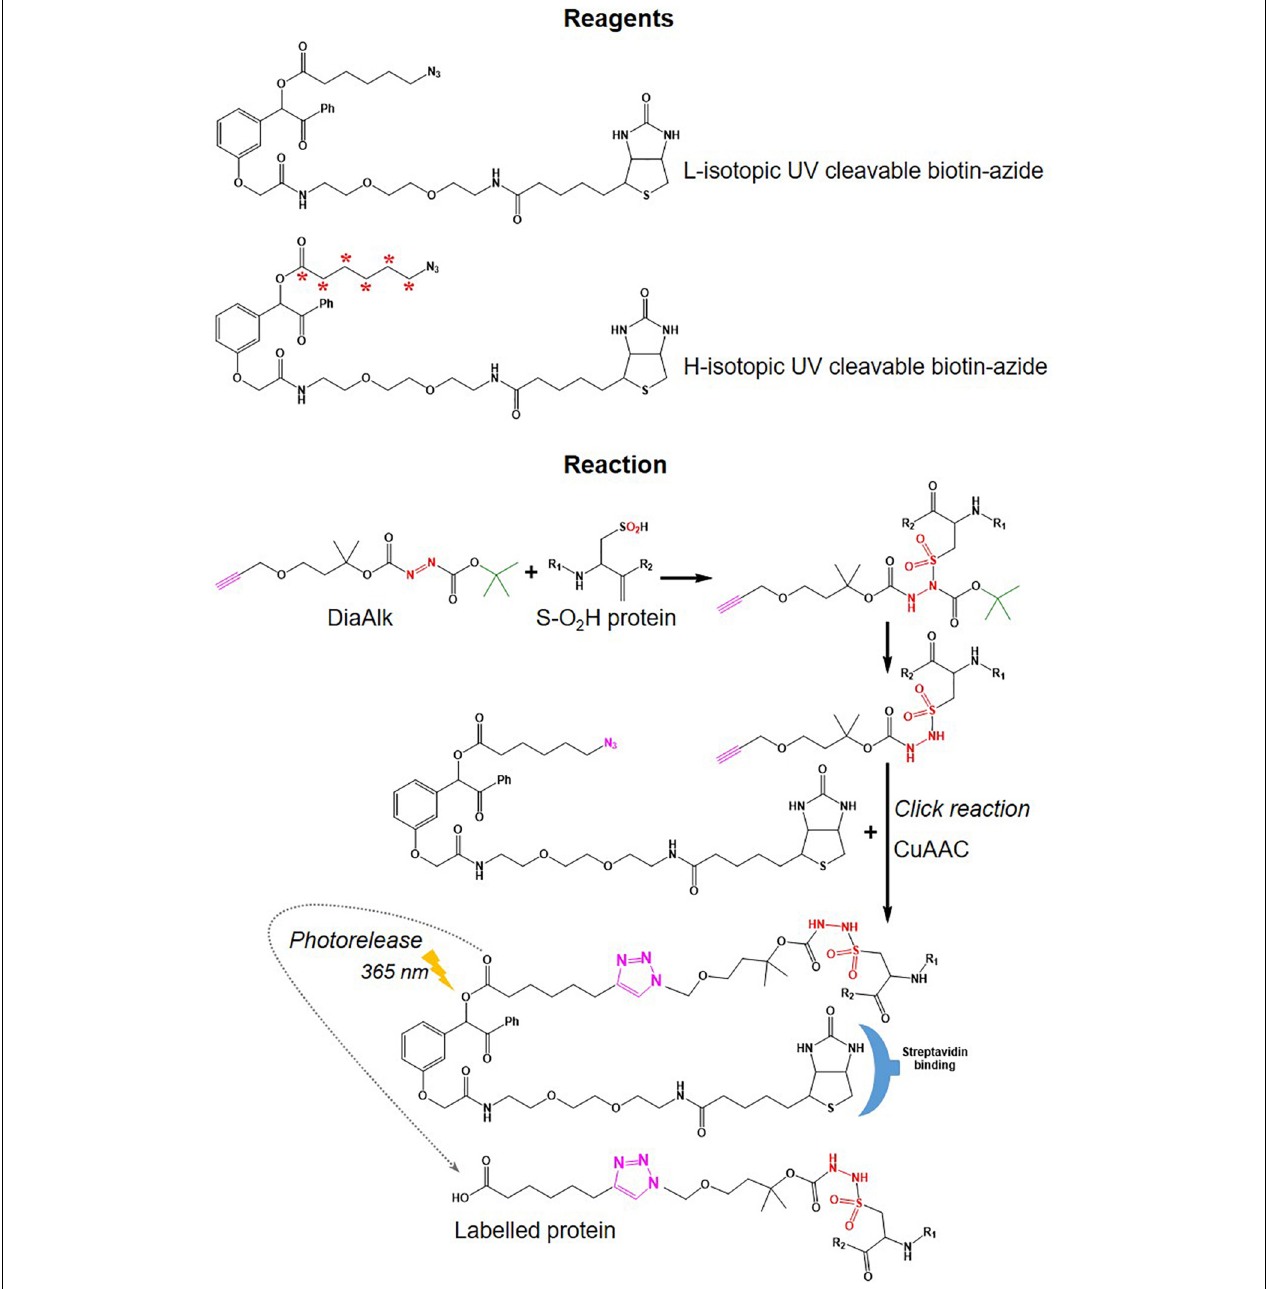
FIGURE 8 | Tags used in DiaAlk workflows. Structure of UV-biotin tags used in DiaAlk and their reaction with oxidized Cys ( S -0 2 H), purification using streptavidin, and release of labeled proteins by UV